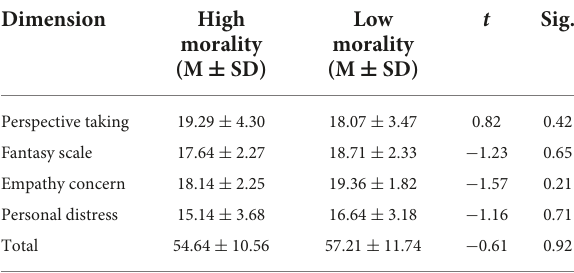
TABLE 1 The Interpersonal Reactivity Index-C result.